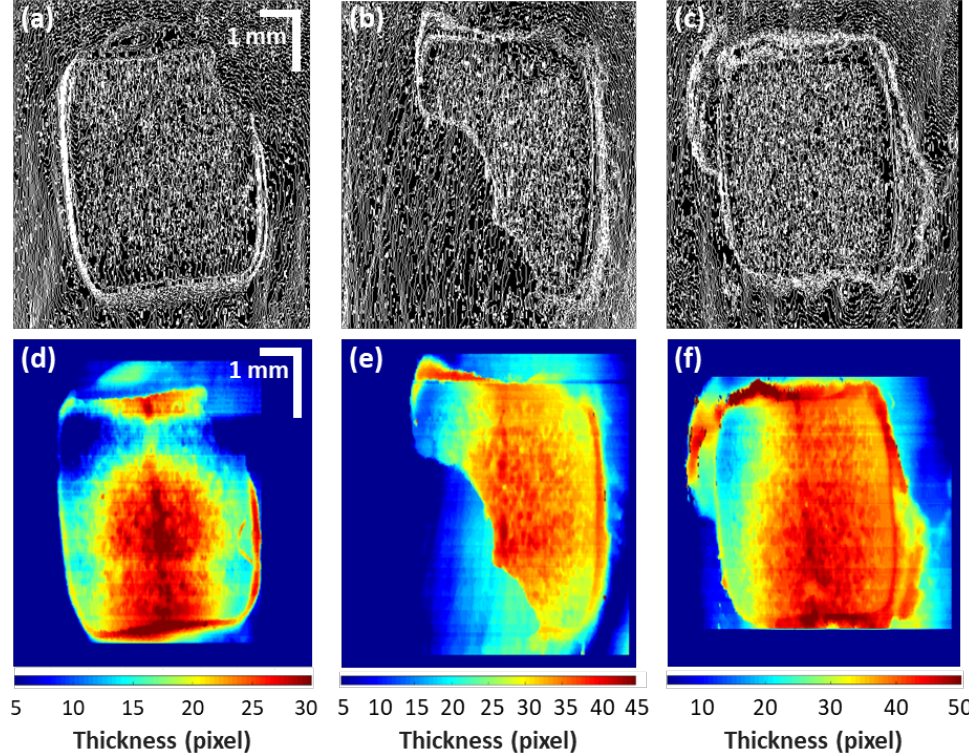
Figure 5. These are images obtained through custom algorithm: ( a – c ) are in-front images that compare the height differences on the surface of the OCT image for each sample; ( d – f ) are images that appear at the end of the algorithm, indicating only the areas judged to be residual adhesives, and expressing information about the thickness of the remaining adhesives in color.